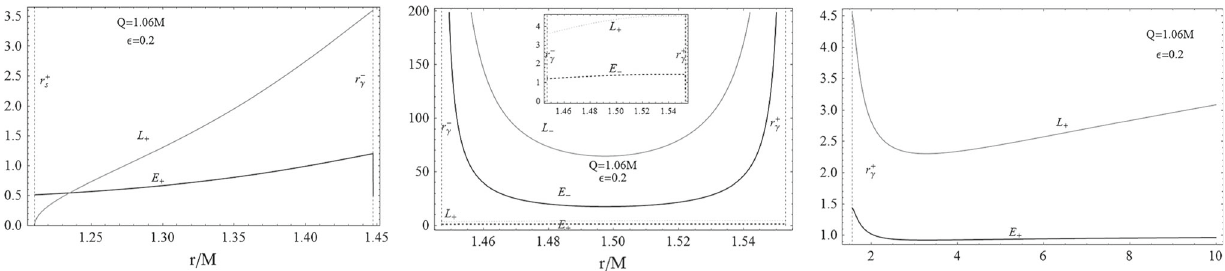
√ √ Fig. 19 Class : ( 3 6 / 7 ) M ≤ Q ≤ 9 / 8 M and (cid:2) l < (cid:2) ≤ (cid:9)(cid:9) (cid:2) − . tum L = L − ( gray curve ) and energy E = E − ( black curve ) in r + s < r < r − γ ; L = 0 at r = r + s ( left plot ); L = L ± in r − γ ≤ r < r + γ Parameter choice is as follows: Q = 1 . 06 M and (cid:2) = 0 . 2. Then (cid:2) = 0 . 0998397, (cid:9)(cid:9) (cid:2) − = 0 . 536564, r + = 1 . 21047 M , r − = 1 . 44708 M , ( center plot ); and L = L − in r ≥ r + γ ( right plot ) γ l s and r + γ = 1 . 55292 M . Circular orbits exist with angular momen-